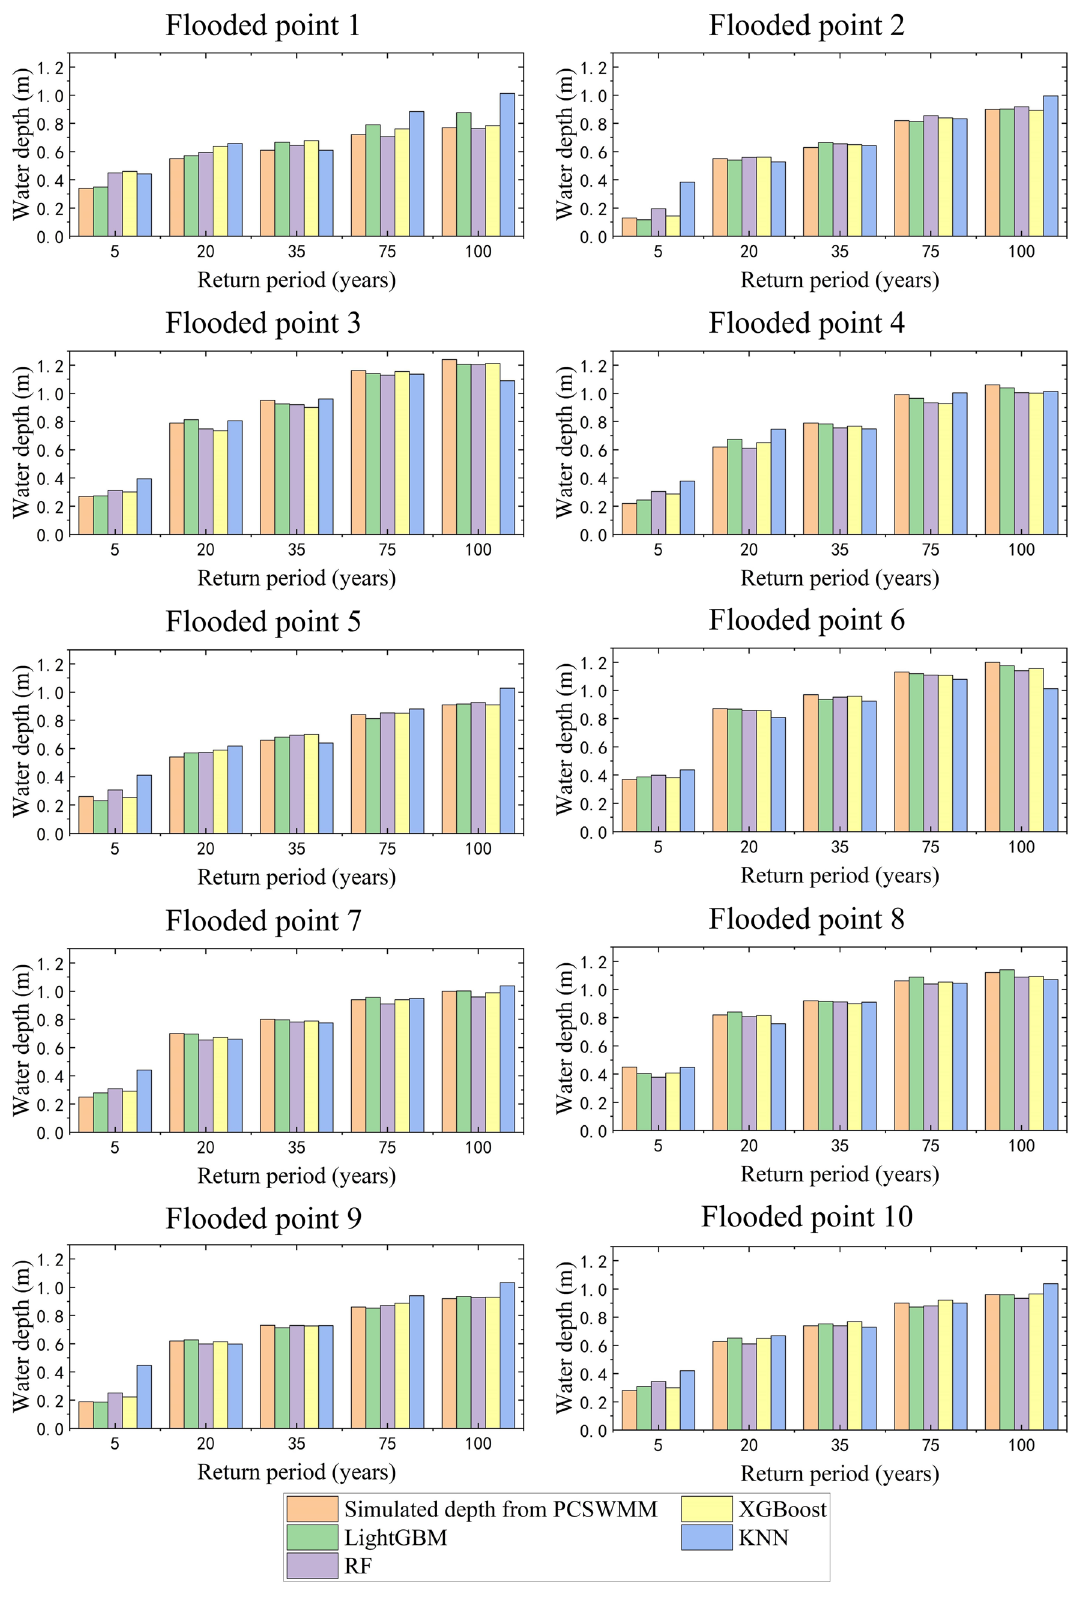
Fig. 13 The prediction results of each model for the 10 flood-prone points in the Haidian Island study area on Hainan Island, China under differ- ent return